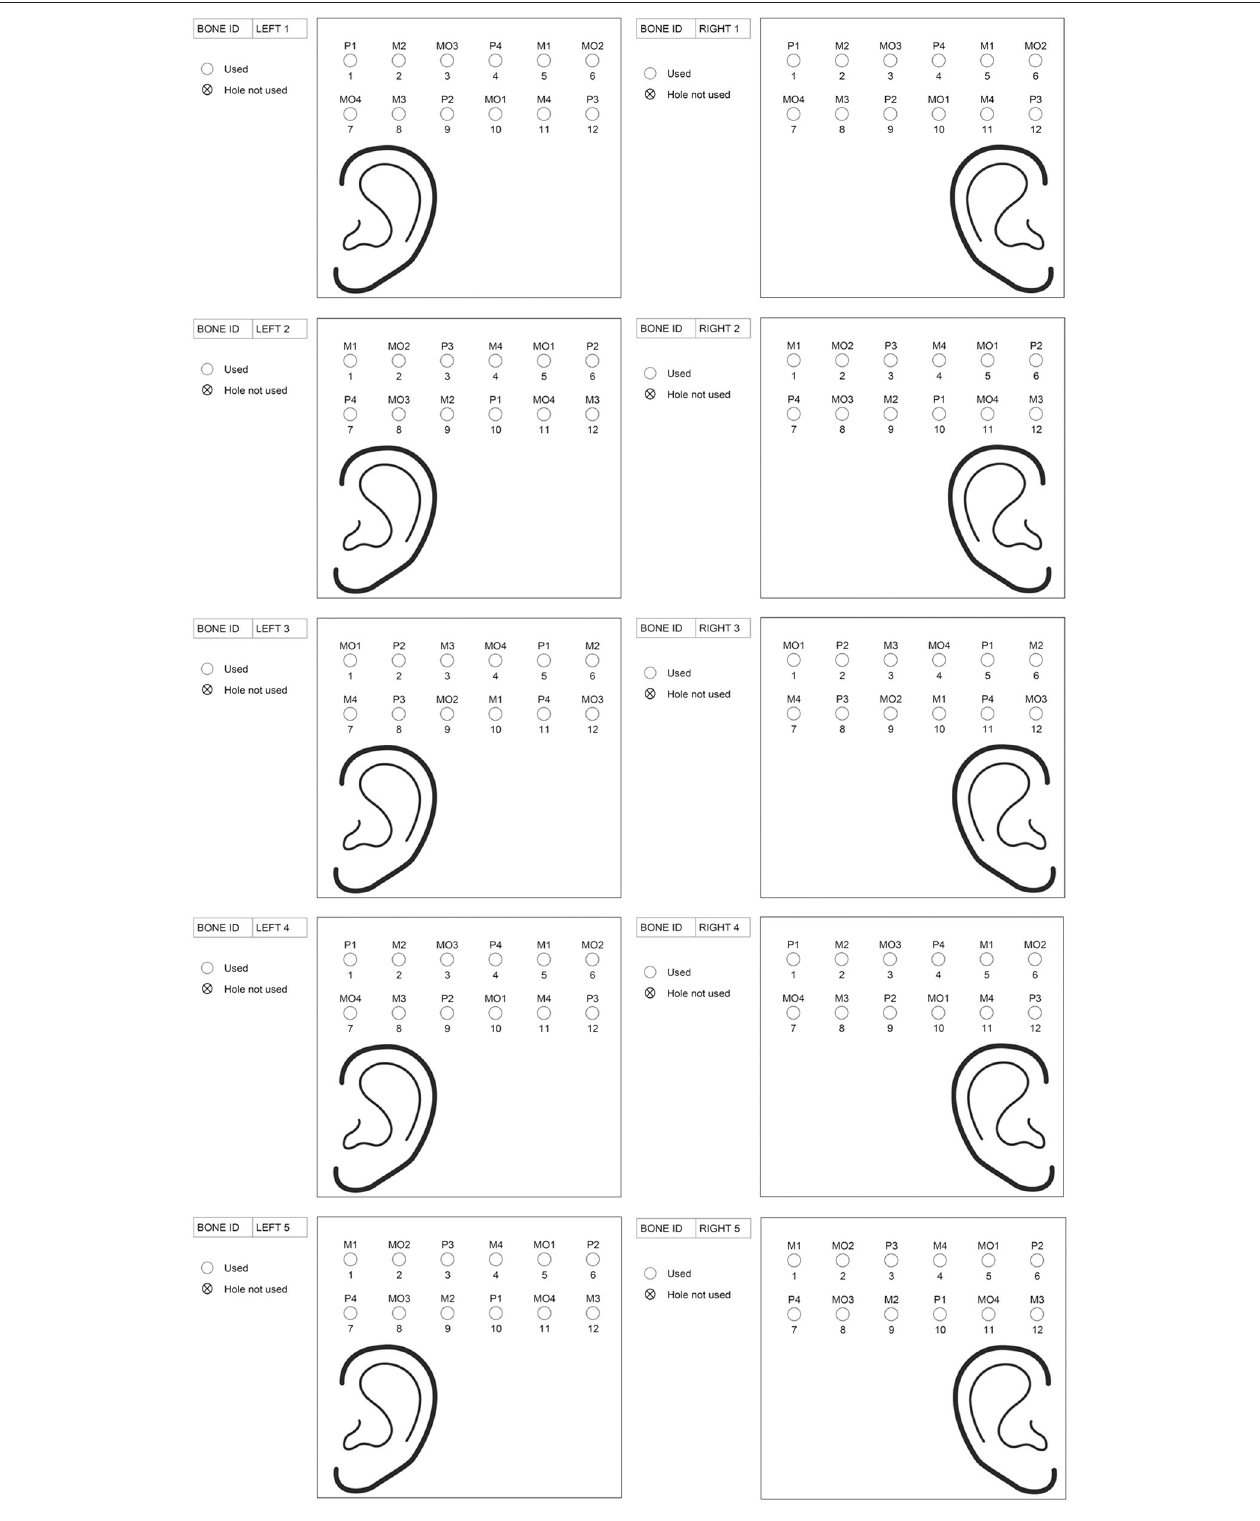
FIGURE 2 | The predetermined randomized schedule with the drill sites for the different drills and penetration depths. The abbreviations used for the drilling systems are P = Ponto guide drill, M = MIPS guide drill and MO = MONO. The numbers behind the drilling systems indicate the penetration depth (e.g., P2 means Ponto guide drill with a penetration depth of